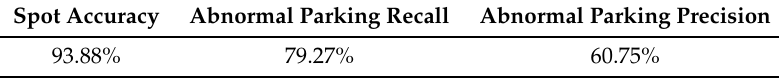
Table 3. Performance of our system in a challenging parking lot